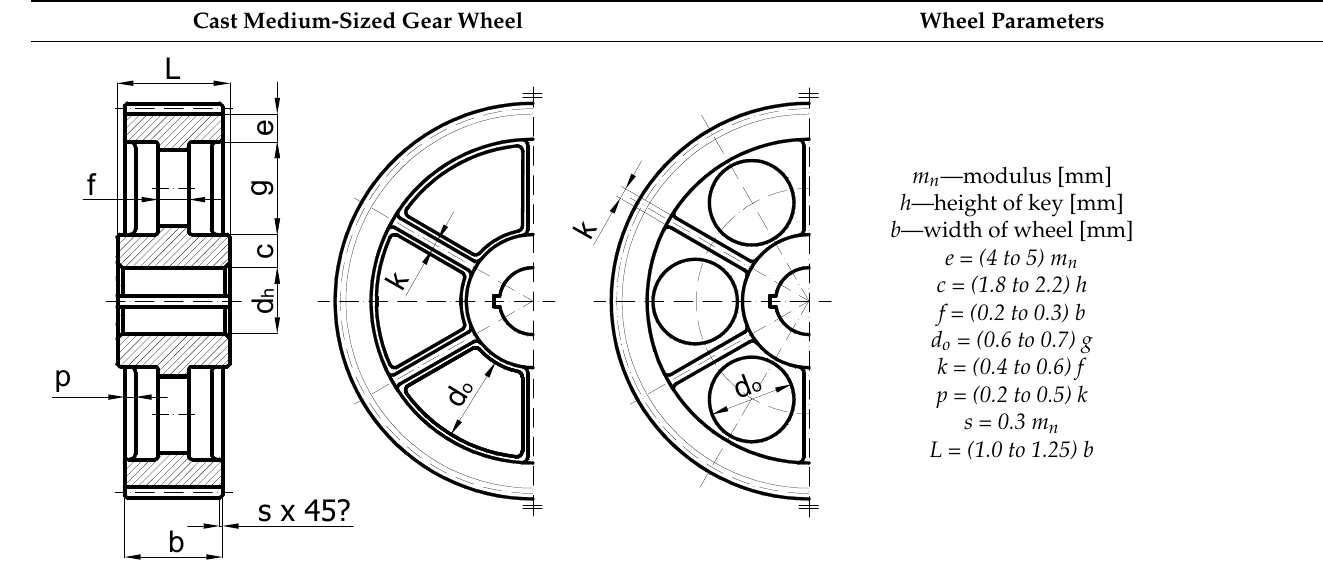
Table 3. Cast medium-sized spur gear: basic geometric parameters.